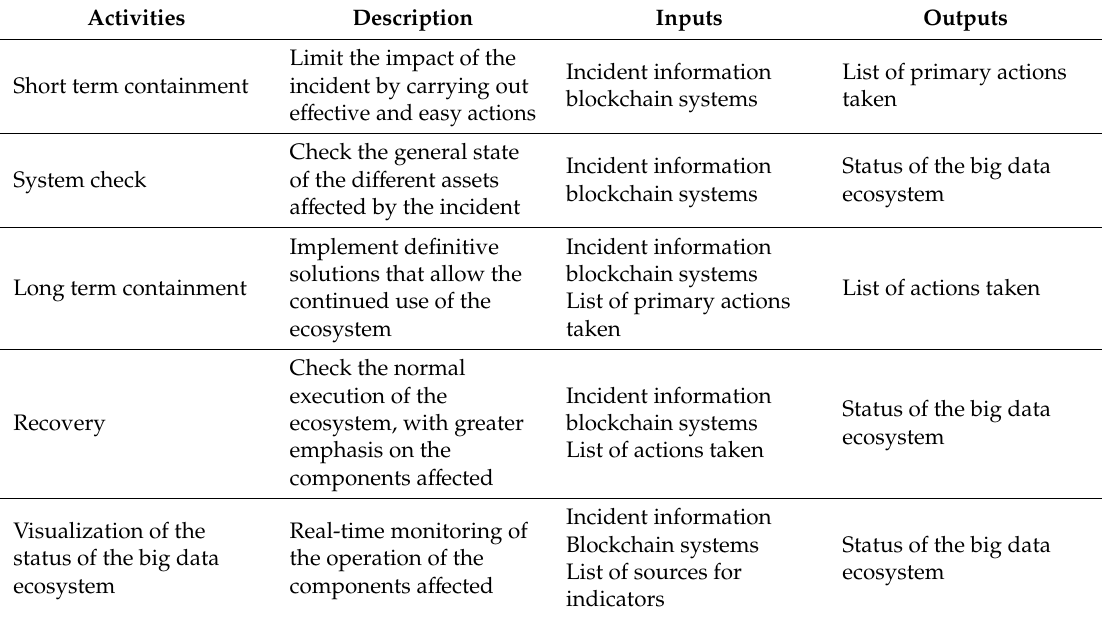
Table 6. Activities of Phase 4: Containment, eradication and recovery.